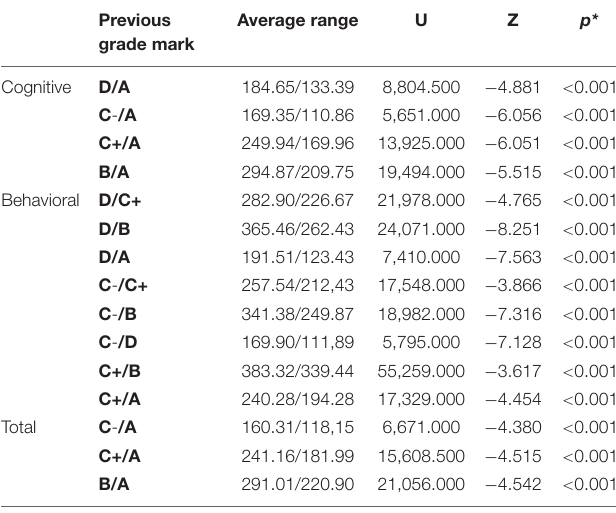
TABLE 7 | Comparison (Mann–Whitney’s U with Bonferroni correction) of test anxiety components between levels of academic performance. Previous grade mark